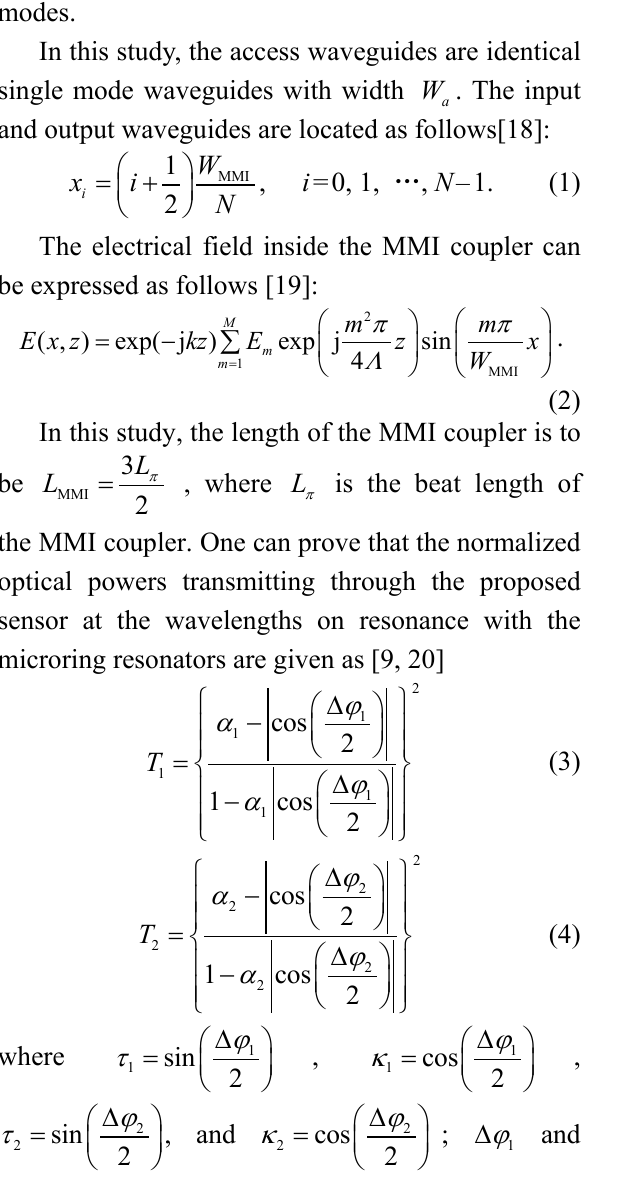
Fig. 2 FDTD simulations for two-channel sensors: (a) glucose, (b) ethanol, and (c) mask